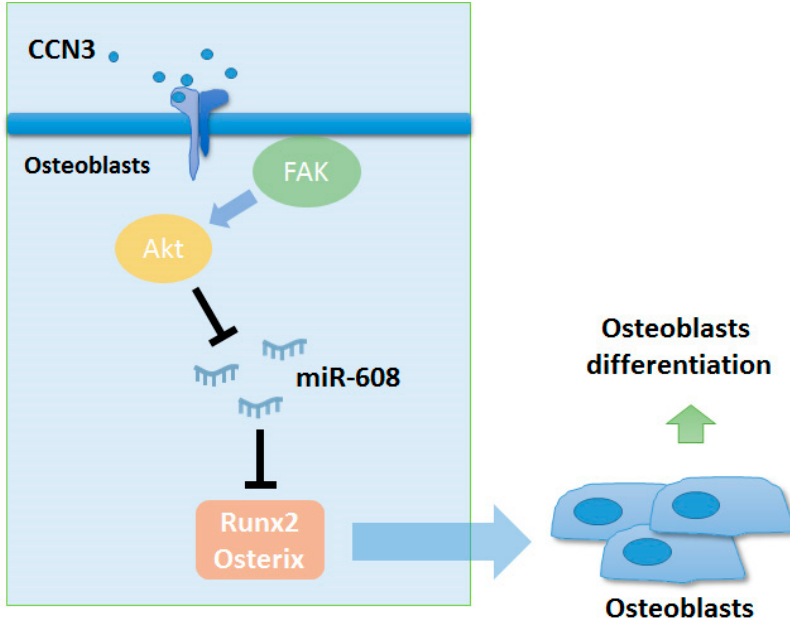
Figure 6. Schematic diagram summarizes the mechanism whereby CCN3 promotes Runx2 and osterix expression in osteoblasts. CCN3 promotes the expression of osteogenic transcriptional factors Runx2 and osterix in osteoblasts by downregulating miR-608 through the focal adhesion kinase (FAK) and Akt signaling pathway.